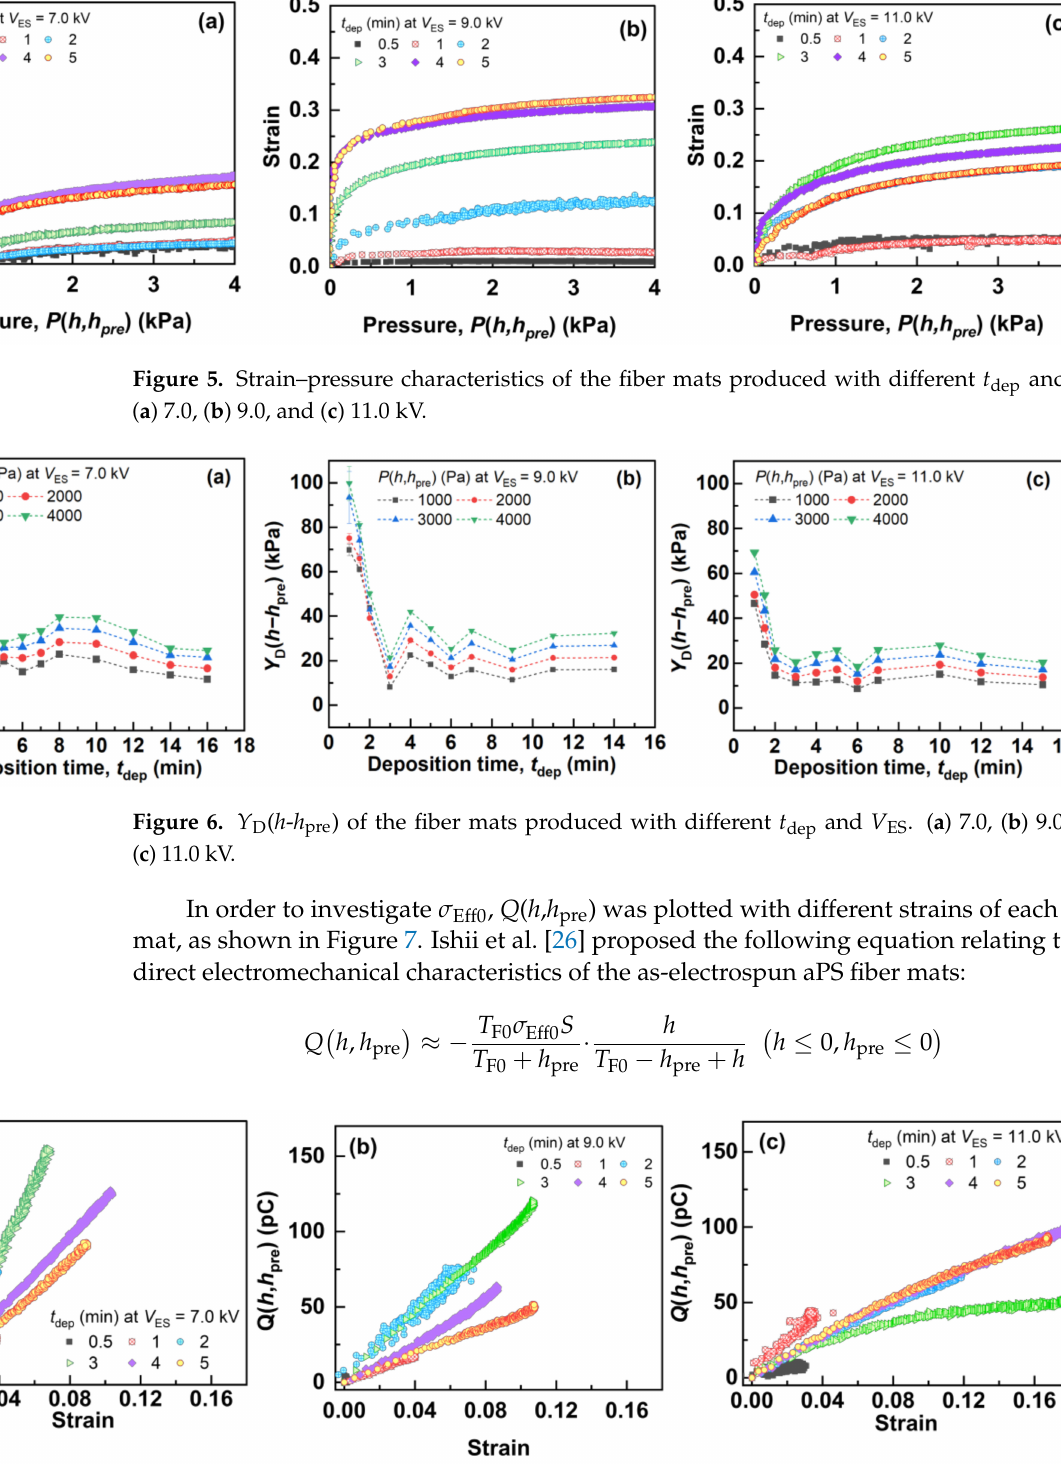
Figure 7. Q ( h , h pre ) with different strains of the fiber mats produced with different t dep and V ES . ( a ) 7.0, ( b ) 9.0, and ( c ) 11.0